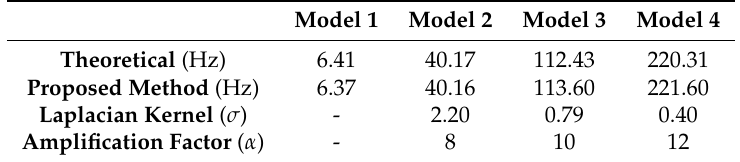
Table 1. Identified modal frequencies and analysis parameters in the beam